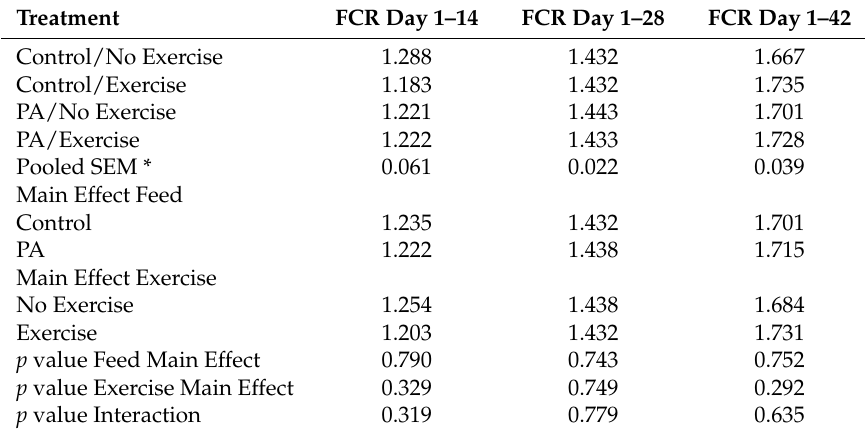
Table 4. Feed conversion ratio during growout in Experiment